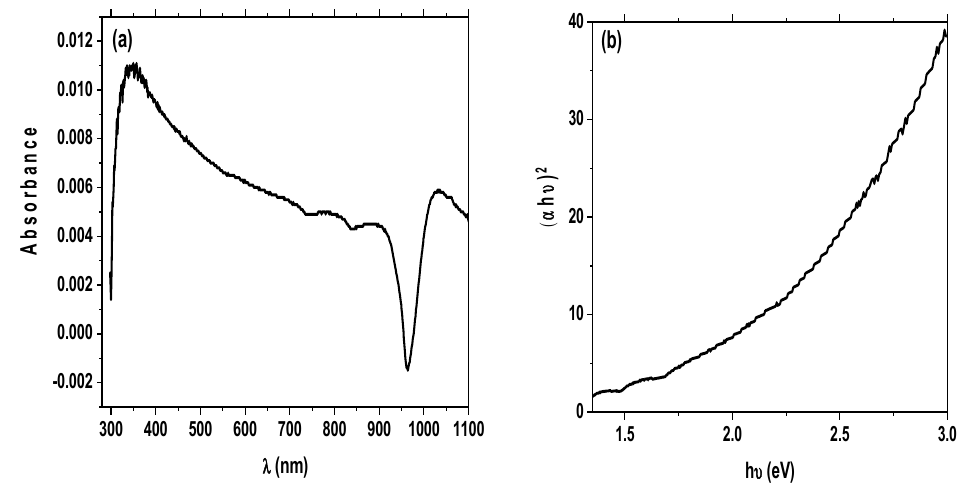
Figure 9. ( a ) Room-temperature UV–visible absorption spectrum of the prepared silica nanoparticles; ( b ) plot of ( α h ν ) 2 versus (h ν ) for the prepared synthesized SiO 2 NPs nanoparticles.